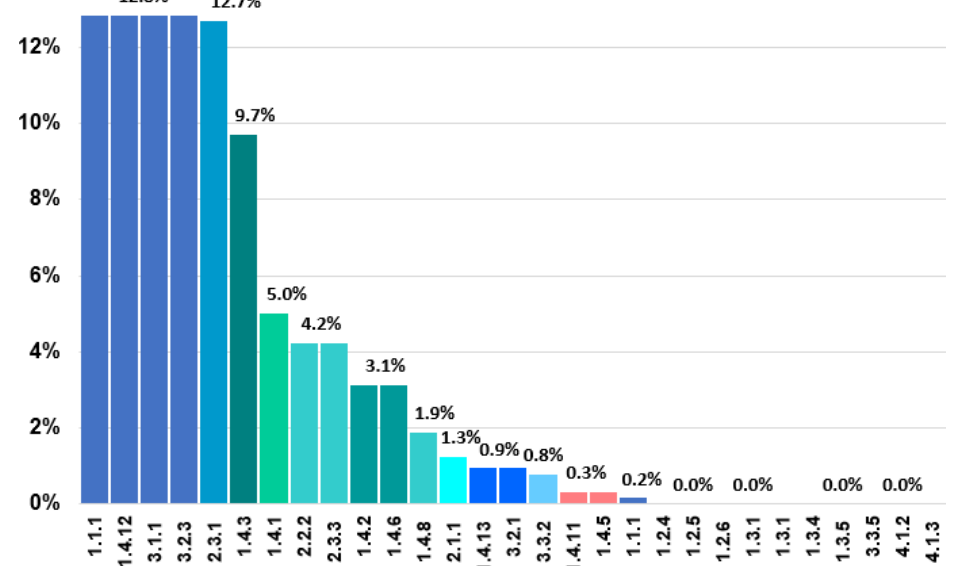
Figure 6. Success criteria in manual evaluation that exceed the barriers.